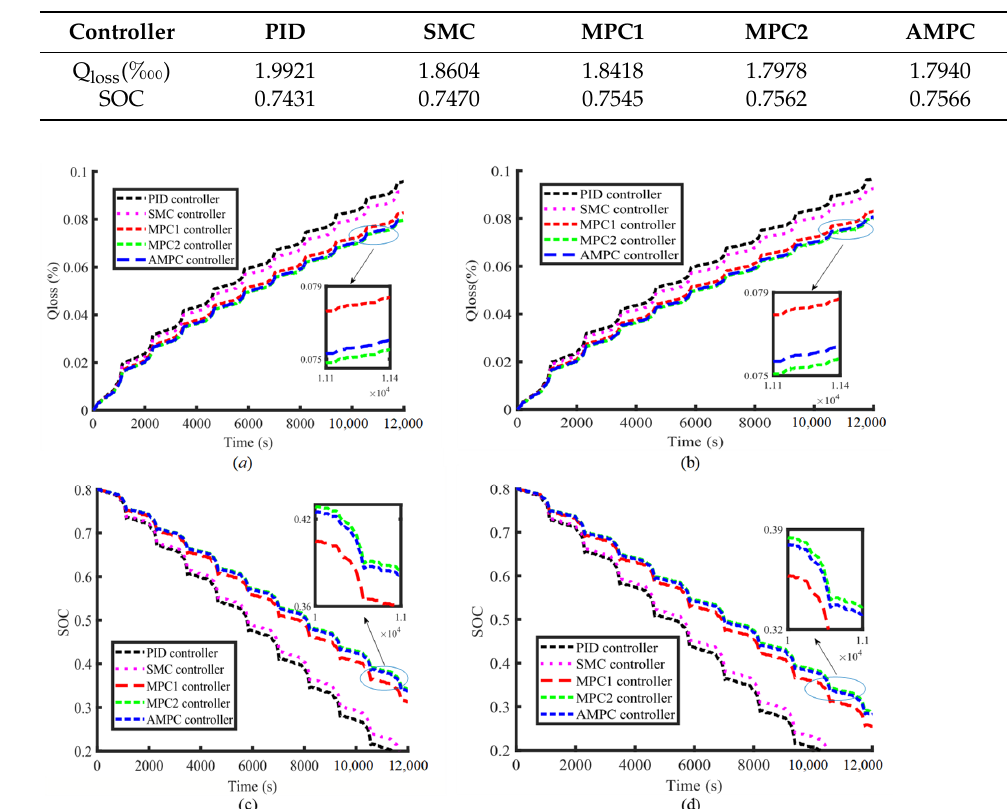
Figure 19. Under 10 NEDCs, the ba tt ery parameters under the action of each controller: when SOH = 1, ( a ) ba tt ery capacity loss ( c ) SOC. When SOH = 0.9, ( b ) ba tt ery capacity loss ( d ) SOC.